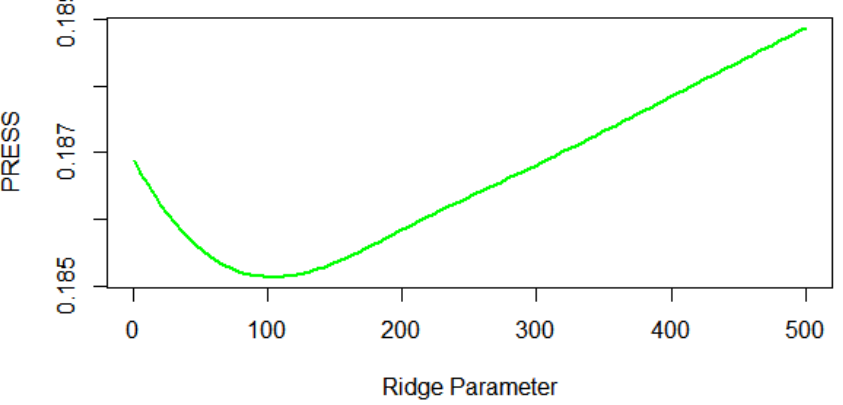
Figure 4. Cross-validated estimates of the mean squared errors as a function of the ridge